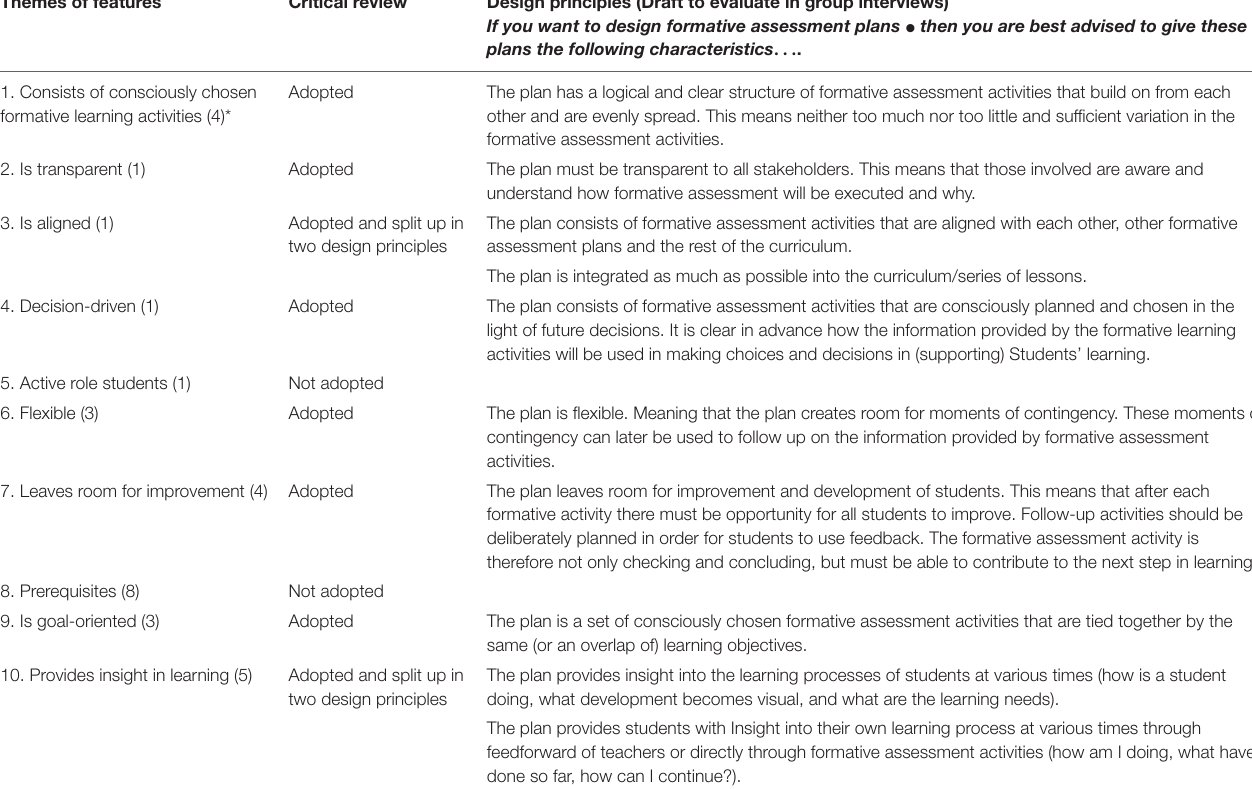
TABLE 5 | Results of thematic analysis.